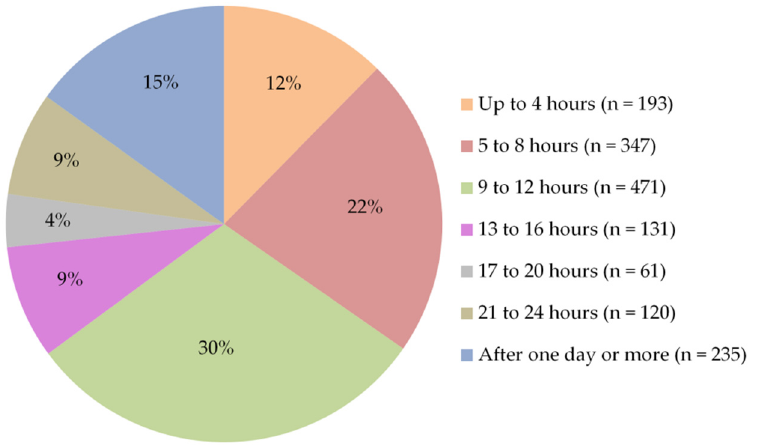
Figure 7. Participants’ answers to the question “How soon did the post-vaccination side effects appear after the injection?”